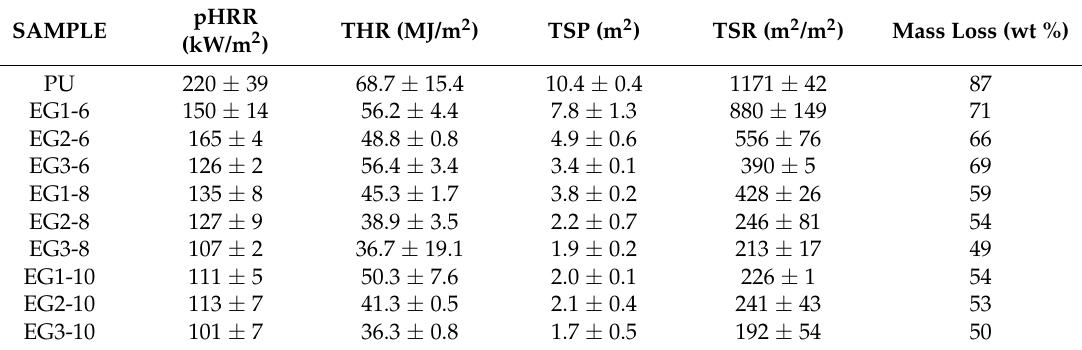
Figure 6. ( a ) Heat release rate (HRR), ( b ) Total heat released (THR), and ( c ) Total smoke production (TSP) curves for RPUF samples containing EG1, EG2, and EG3 at 10 wt % loading. Table 5. Data of EG/RPUF composites at 50 kW/m 2 from cone calorimeter test.